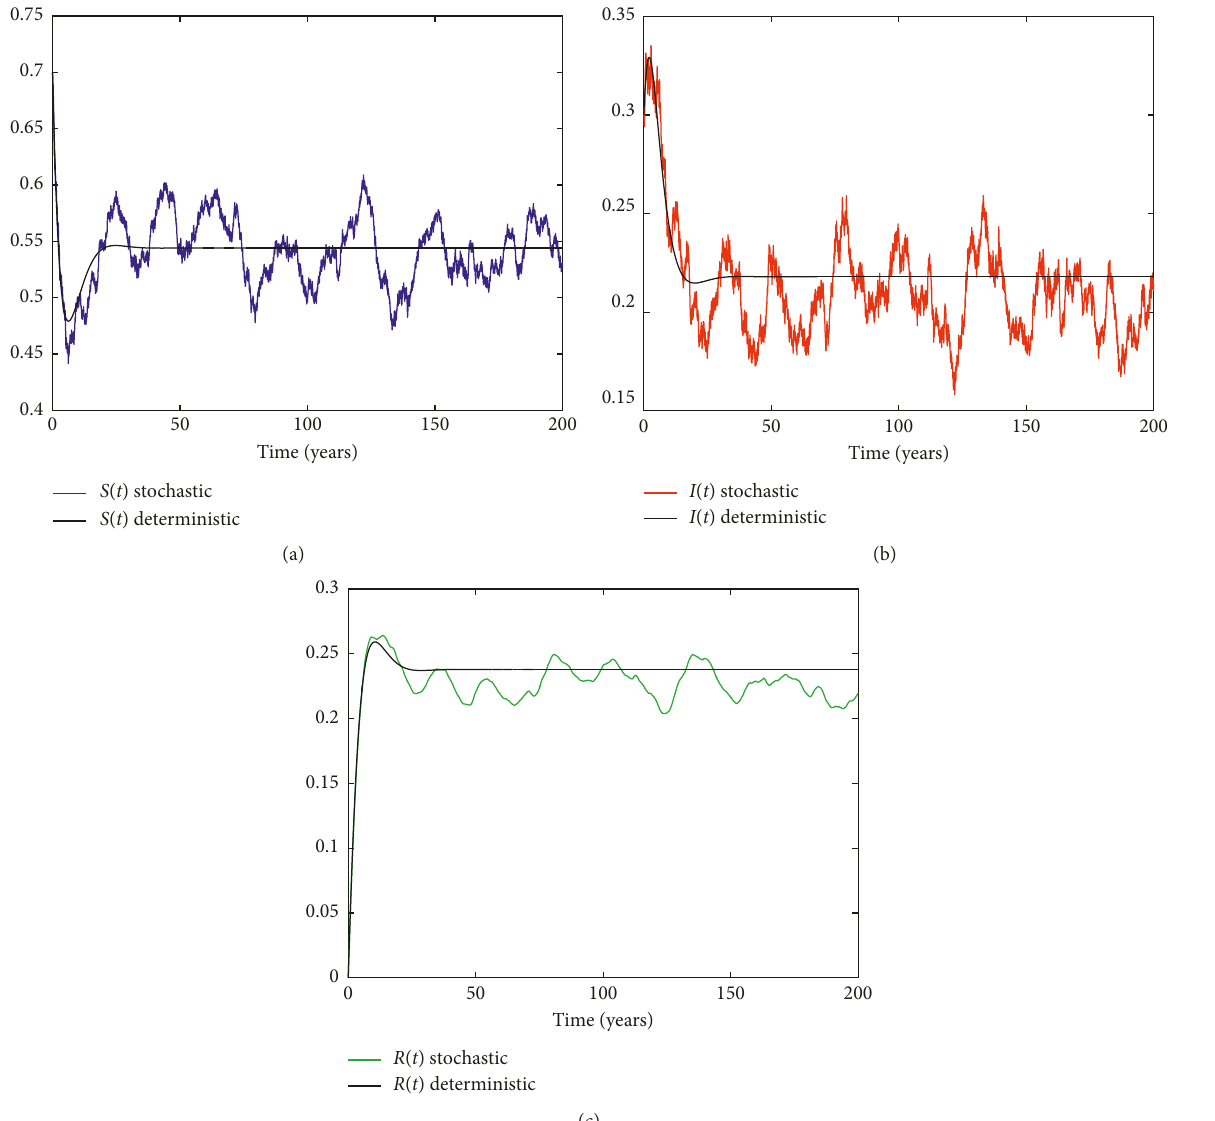
Figure 3: Simulations of the path (a) S ( t ), (b) I ( t ), and (c) R ( t ) for the deterministic system (1) and the corresponding stochastic system